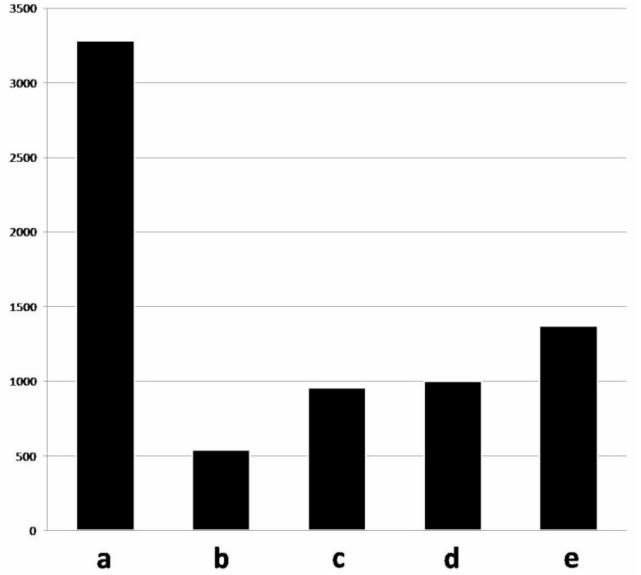
Figure 5. Main features of the training set. Overall,3283 lungs were recognized as healthy ( a ), while EP-like lesions were detected in the remaining 3871 pictures ( b + c + d + e ). The size of the lesion was <2% of the entire lung surface in 541 cases ( b ), between 2 and 5% in 958 cases ( c ), between 5 and 10% in 1001 cases ( d ) and >10% in 1371 pictures ( e ).